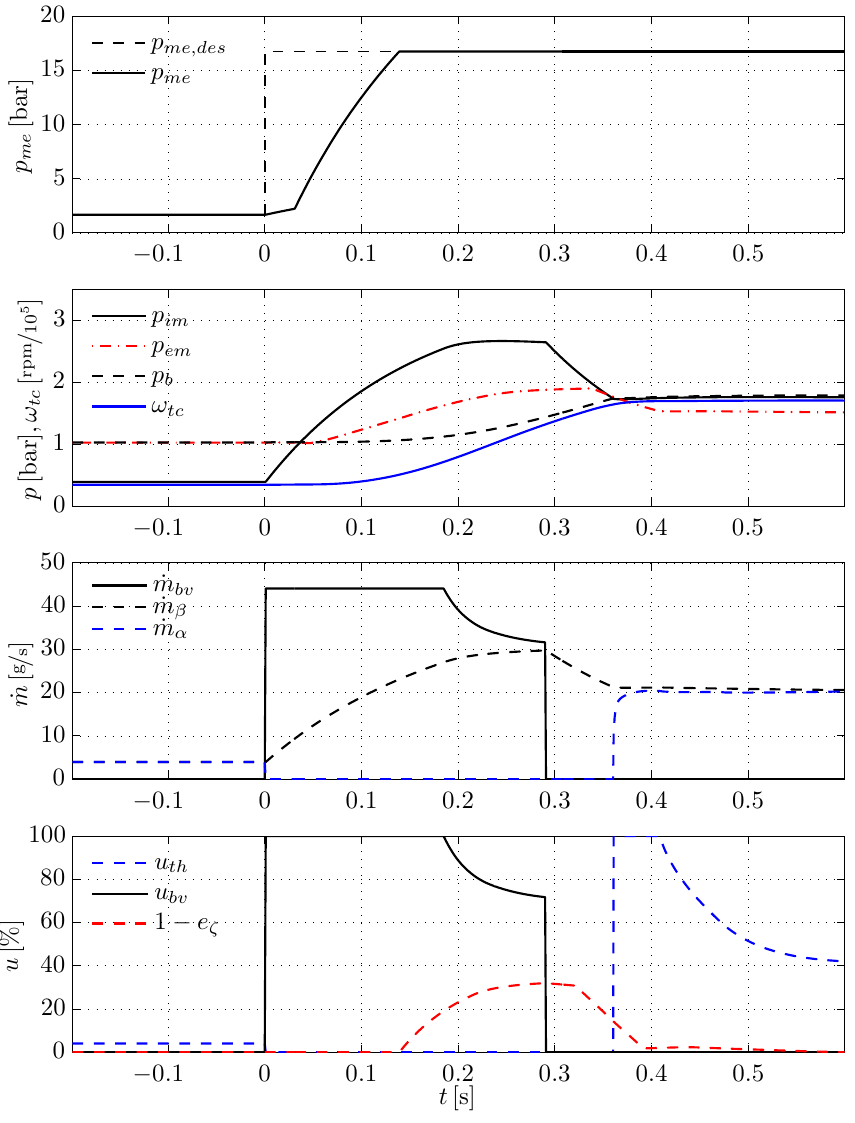
at 2000 rpm, with ν = ν = 1 . 5 me ob ob,max